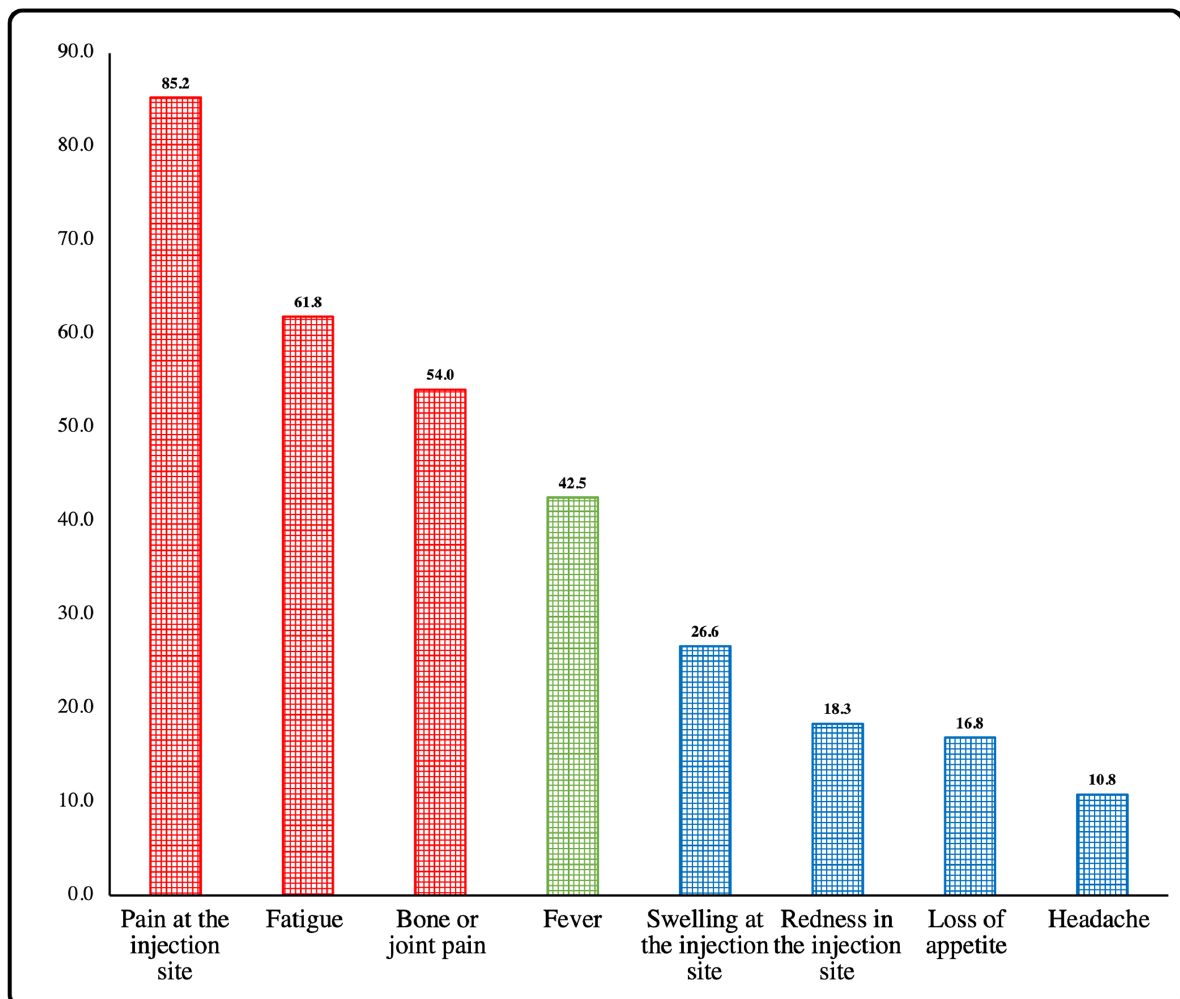
Figure 2. Percentage of common/moderately common, and uncommon side effects among study participants.